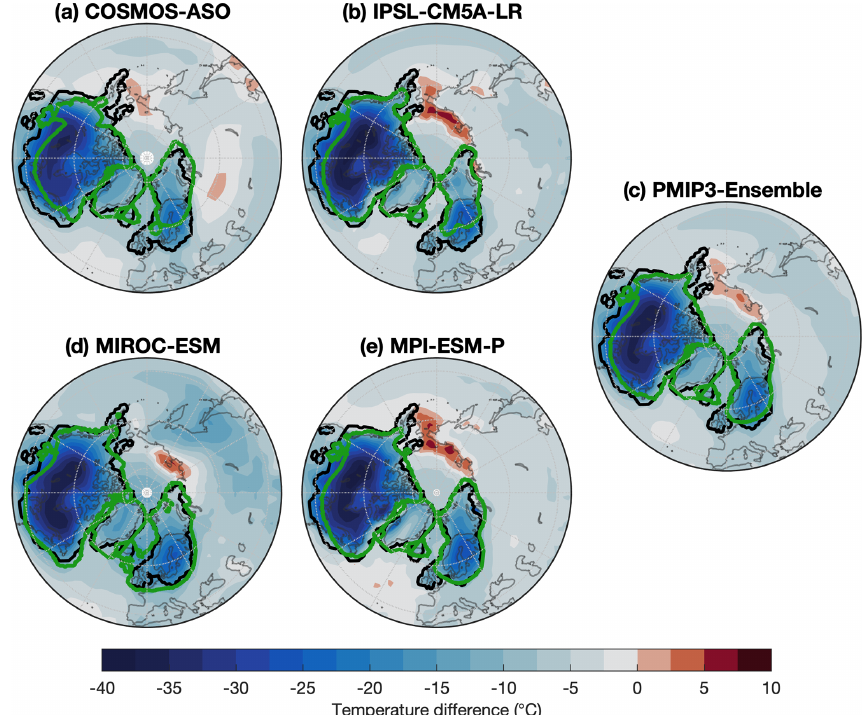
Figure 5. Summer (JJA) temperature differences between the LGM and PI. IPSL and MPI have lower temperatures in Arctic Canada compared to the other GCM climates, which results in larger rates of ice growth at the onset of the LGC. Black contours represent the LGM extent of the Abe-Ouchi et al. (2015) ice sheets. The LGM extent of the ice sheet model simulations is shown in